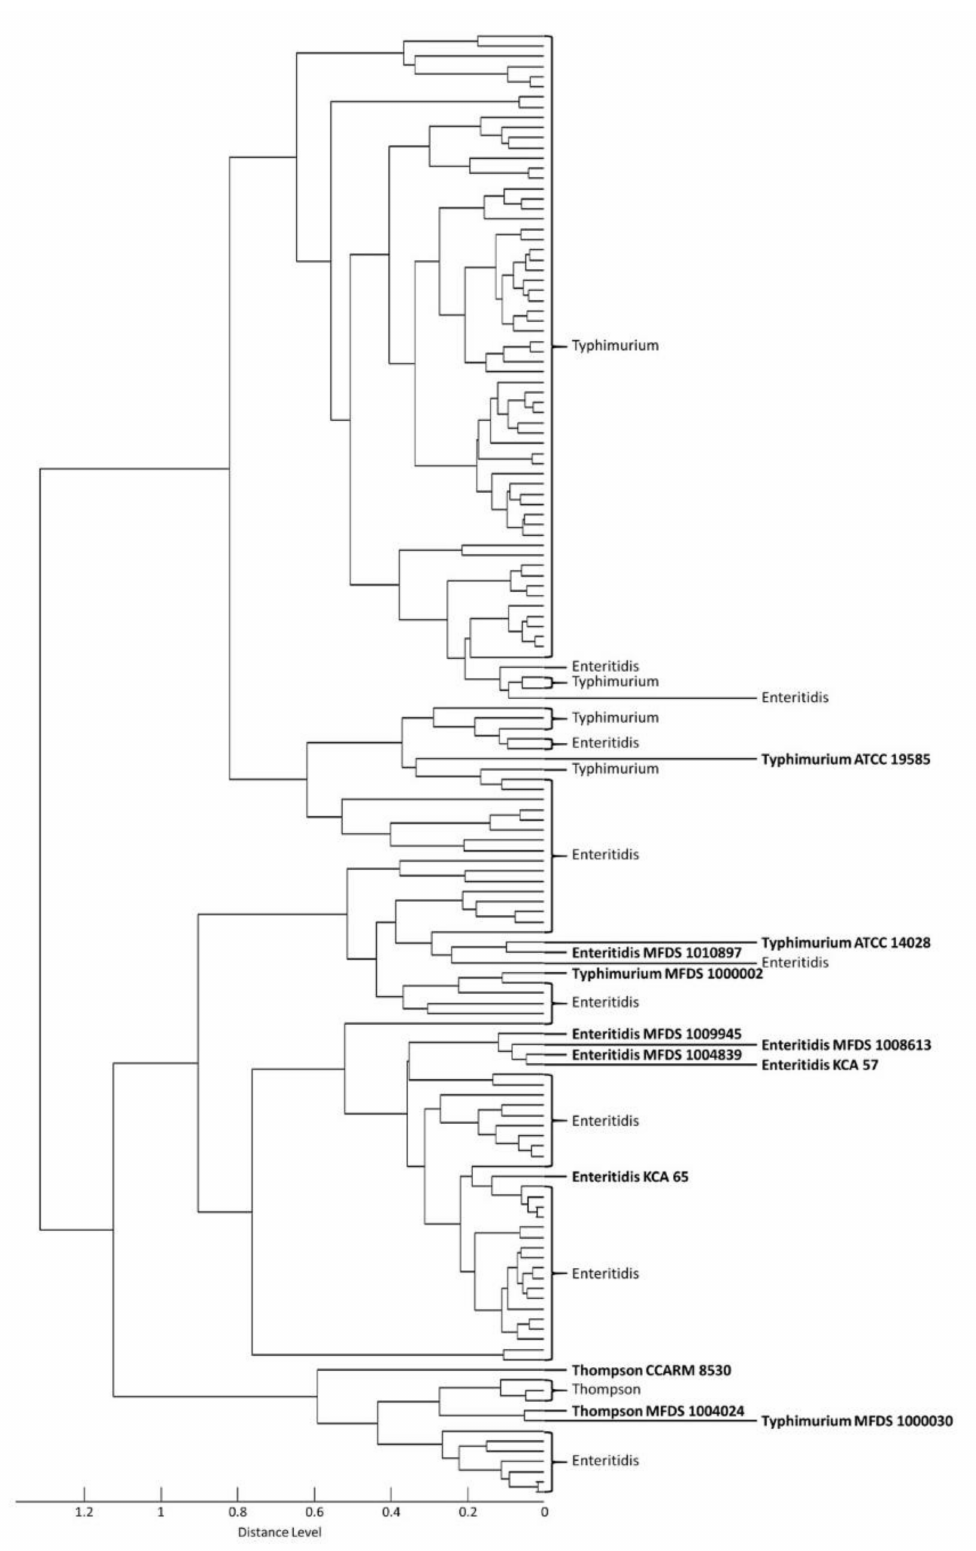
Figure 1. Main spectrum profile (MSP) dendrogram generated based on m / z values and relative intensities of 12 reference strains and 132 isolates. Bold indicates reference